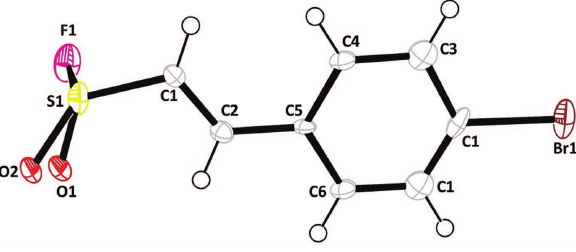
Table 1: Data collection and handling.